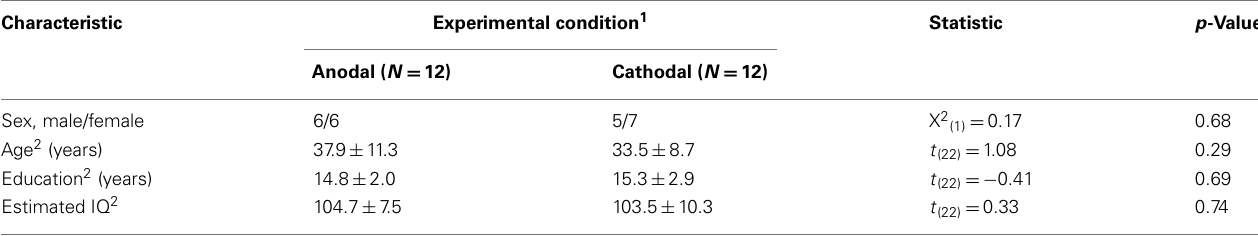
Table 1 | Characteristics of study participants by experimental